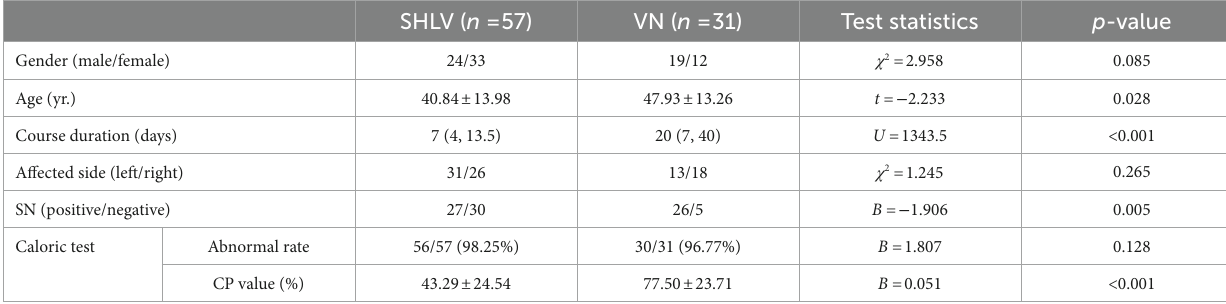
TABLE 1 Demographic and clinical characteristics of SHLV and VN